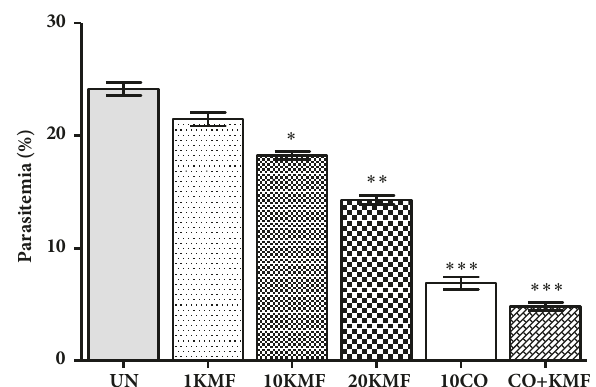
Figure 2: Antimalarial effect of kaempferol on PbANKA in a prophylactic test. Groups of ICR mice (3 mice per group) were given 1, 10, and 20mg/kg of kaempferol by oral gavage for 4 consecutive days (days 0-3). Untreated and positive control mice received 10ml/kg of DW and 10mg/kg of CQ, respectively. A combination treatment with 10mg/kg of CQ and 20 mg/kg of kaempferol was also undertaken. Starting on day 4, the mice were inoculated with 1x10 7 PbANKA parasitized erythrocytes by IP injection for 4 days (days 4-7). On day 8, parasitemia was determined by microscopic examination of Giemsa stained thin blood smears. ∗ P < 0.05, ∗∗ P < 0.01, and ∗ ∗ ∗ P < 0.001, compared to untreated control. UN; untreated control, 1KMF; 1 mg/kg of kaempferol, 10KMF; 10mg/kg ofkaempferol,20KMF;20mg/kgofkaempferol,and10CQ;10 mg/kg of chloroquine. The results are expressed as mean ± SEM.